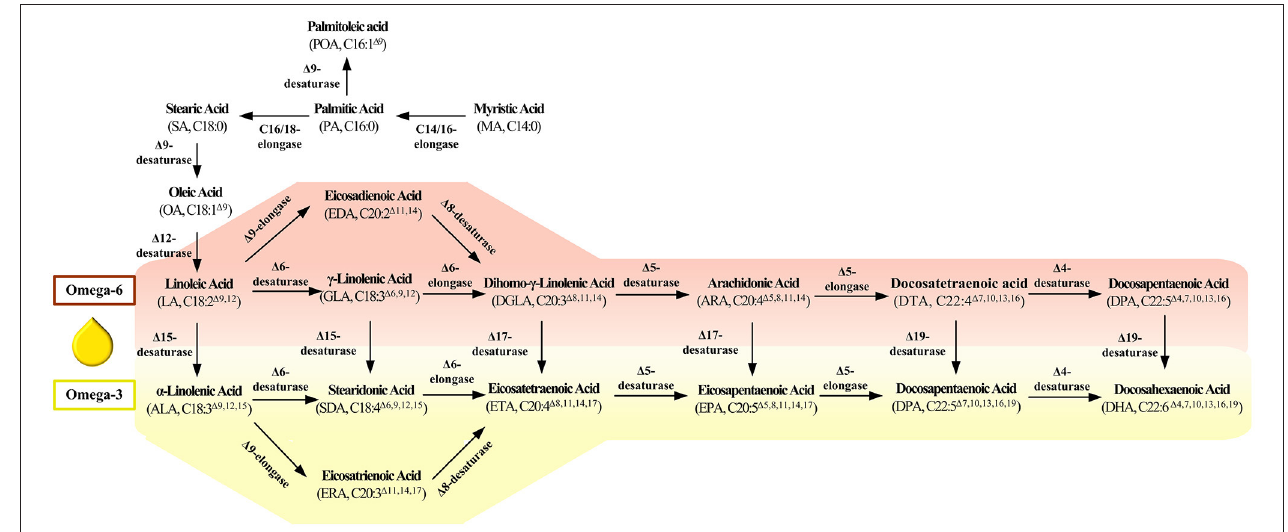
FIGURE 1 | Key enzyme in the fatty acids’ synthesis